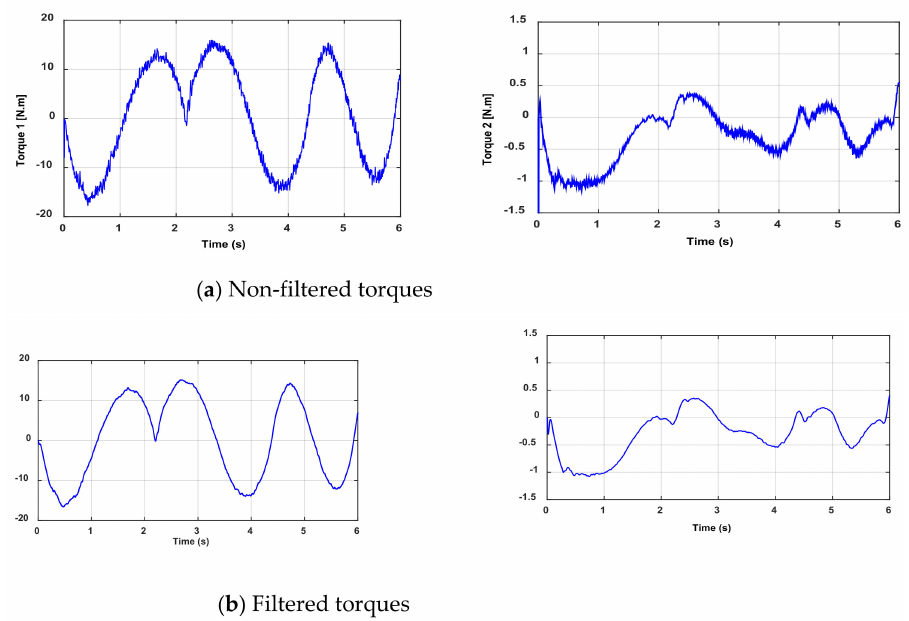
Figure 3. Curves of non-filtered and filtered